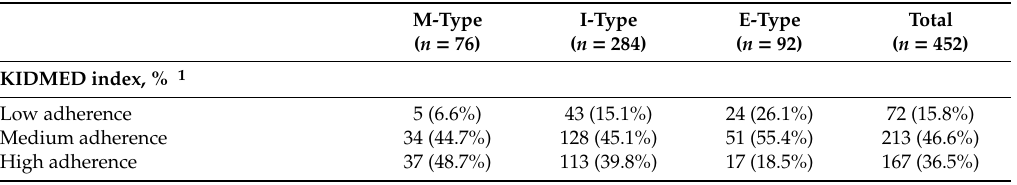
Table 2. Chronotype and KIDMED score, index, and frequency of responses to each test